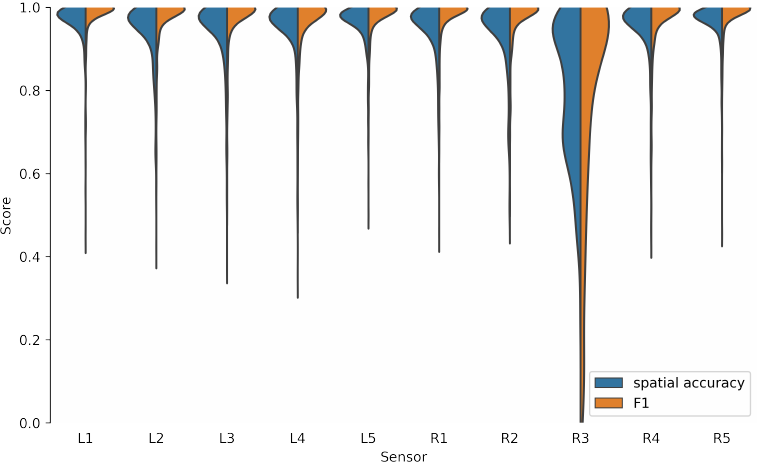
Figure 13. Spatial accuracy (Equation (5)) and F 1 score on test data set for each sensor (Figure 3). The evaluation of the test data took 335 s for 375 passages and 10 sensors with the use of an NVIDIA RTX 3090. The model therefore needs 0.089 s per signal, and for our entire measurement setup, 0.89 s per passage. This would allow for the real-time application of the VAD and is a flexible trade-off between accuracy and computing speed due to the number of sensors